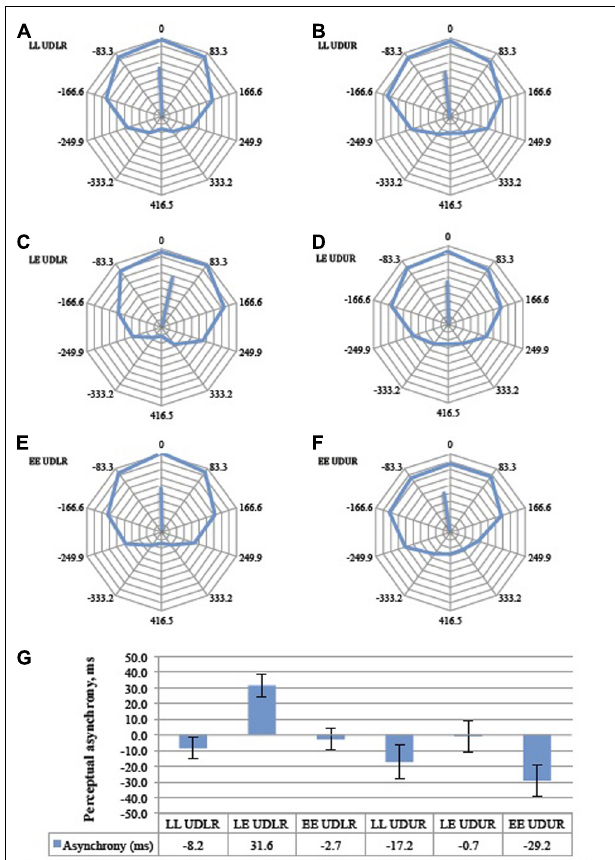
FIGURE 8 |The aggregate response curves for the balanced attention version of the experiment for all 14 subjects for the six trial types (A–F). 360 ◦ represents a period of 833 ms , and each 36 ◦ division represents 83.3 ms.The average angular shifts are summarized in a bar graph (G) , Error bars represent the standard error of the mean. Conventions as in Figure 7